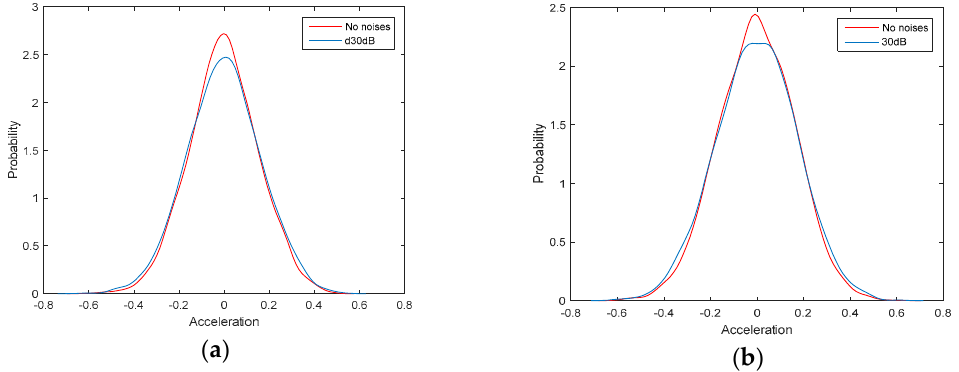
Figure 4 . Observed signal with 30 dB Noises: ( a ) Before damaged; ( b ) Condition 3. Figure 4. Observed signal with 30 dB Noises: ( a ) Before damaged; ( b ) Condition